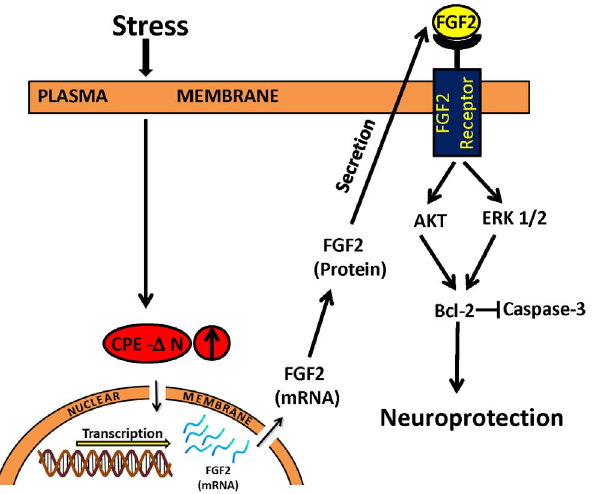
Figure 7. Mechanism of neuroprotection by CPE- D N in embryonic neurons during stress. Stress causes release of glucocorticoid which enhances the expression of CPE- D N in embryonic neurons. CPE- D N is transported into the nucleus and up-regulates the transcription of FGF2 mRNA and subsequent expression of FGF2 protein. The FGF2 is secreted and binds to FGF2 receptors in neurons to activate AKT and ERK signaling pathways which then mediates the up-regulation of expression of BCL-2, an anti-apoptotic protein. BCL-2 inhibits the caspase cascade leading to a decrease in active caspase-3, the apoptotic executioner, thereby resulting in